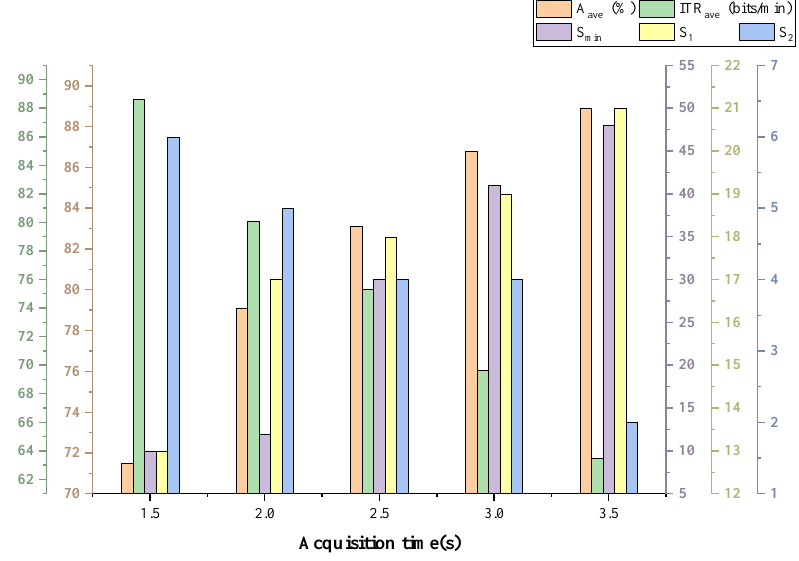
Figure 10. Comparison of different data